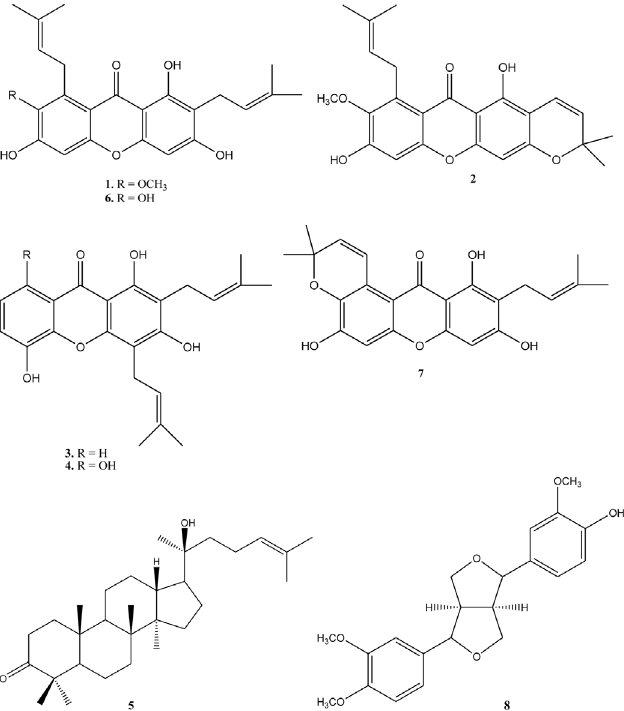
Fig 1. Compounds isolated from of Tetragonula laeviceps propolis. α -mangostin 1, mangostanin 2, 8-deoxygartanin 3, gartanin 4, γ -mangostin 6 and garcinone B 7. The dammarane triterpene dipterocarpol 5 and the furofurane lignane methylpinoresinol 8 were isolated from T . laeviceps